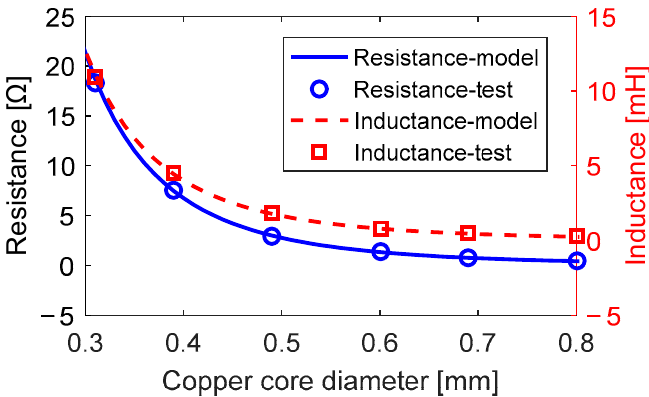
Equation (3) and D core = 0.898 D wire , both R and L were inversely proportional functions vs. D wire 4 (also N 2 ). The model was in good agreement with the experiment as the relative errors of the model in computing R and L were lower than 3.1% and 2.8%, respectively.